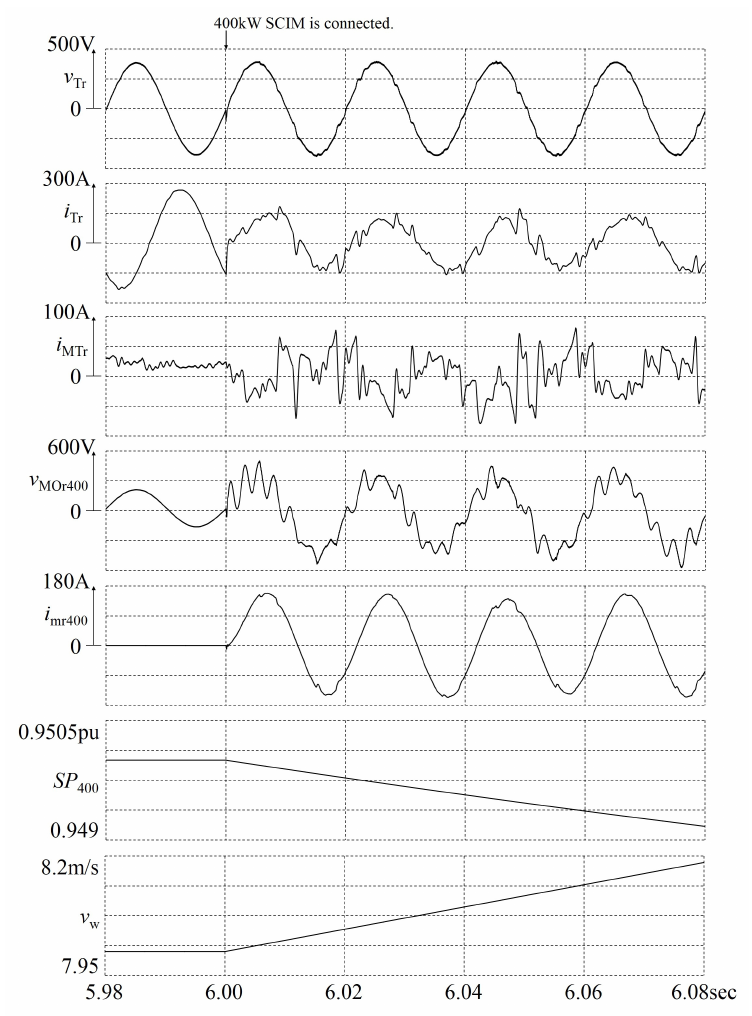
Figure 18. Simulation results with the proposed inrush current suppressor for the 400-kW SCIM when the turn ratio is 1:4. Table 3. Comparison of the simulation